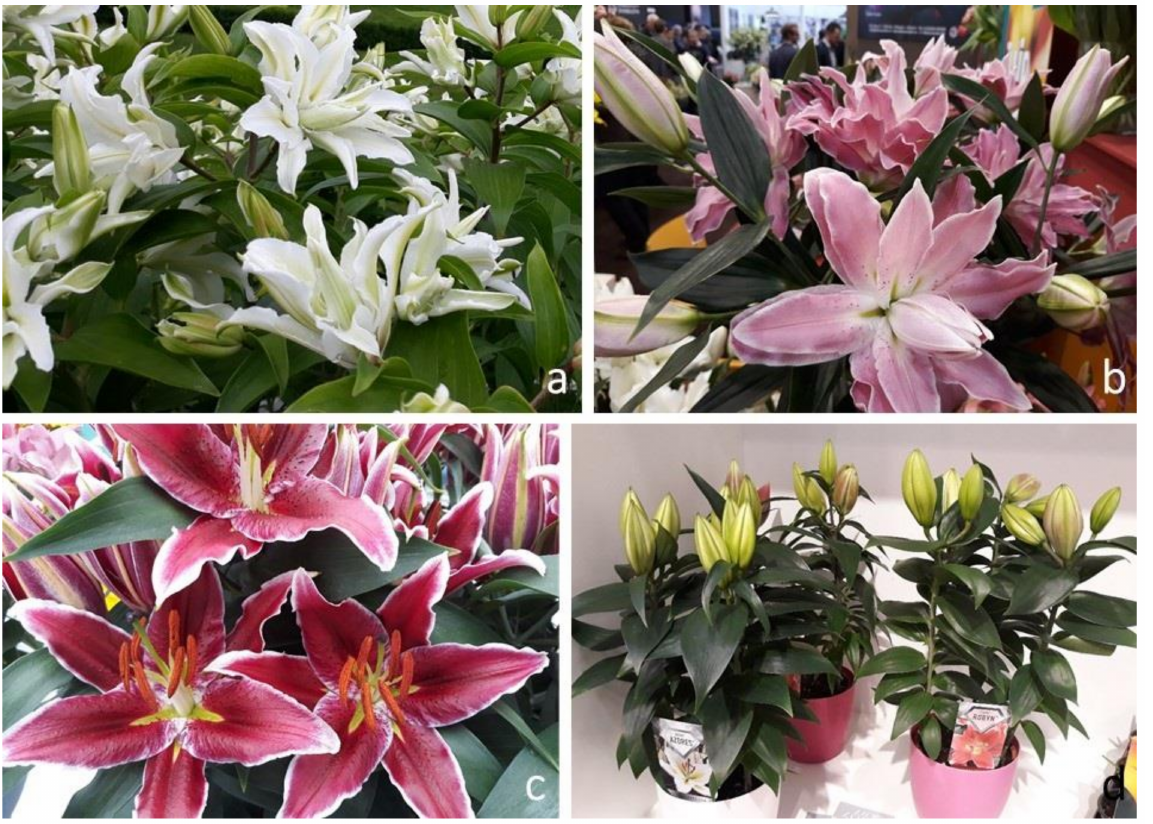
Figure 4. Cultivar novelties of lilies. Double lilies: ( a ) ‘Polar Star’ and ( b ) ‘Diantha’ of the Dutch company C. Steenvoorden, presented at IMP Essen, Germany, 2020. Cultivars for pot production: ( c ) dwarf oriental ‘Magny Course’ and ( d ) Lily Looks series bred by Mak Breeding B.V., the